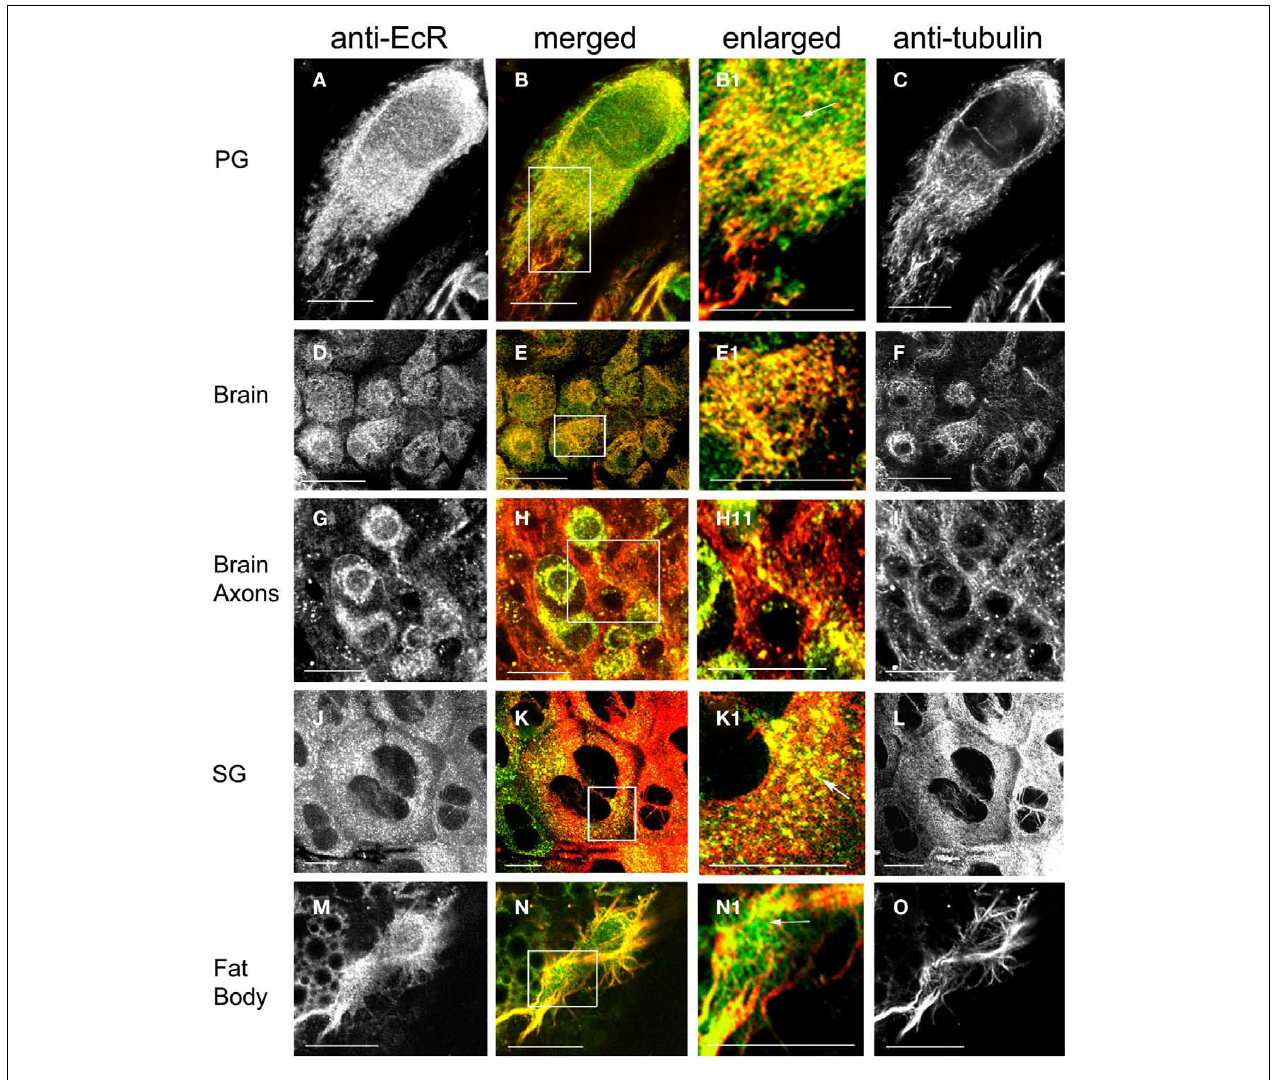
shown in the enlarged column as (B1,E1,H1,K1,N1) respectively; these images show details of co-localization of EcR fluorescence with tubulin fluorescence on MTs. Note the alignment of EcR fluorescence with MTs in these images; this is particularly evident in (H1) that shows an axon. Arrows in (B1,K1,N1) show that not all EcR fluorescence co-localizes with MTs. Scale bars = 10 μ